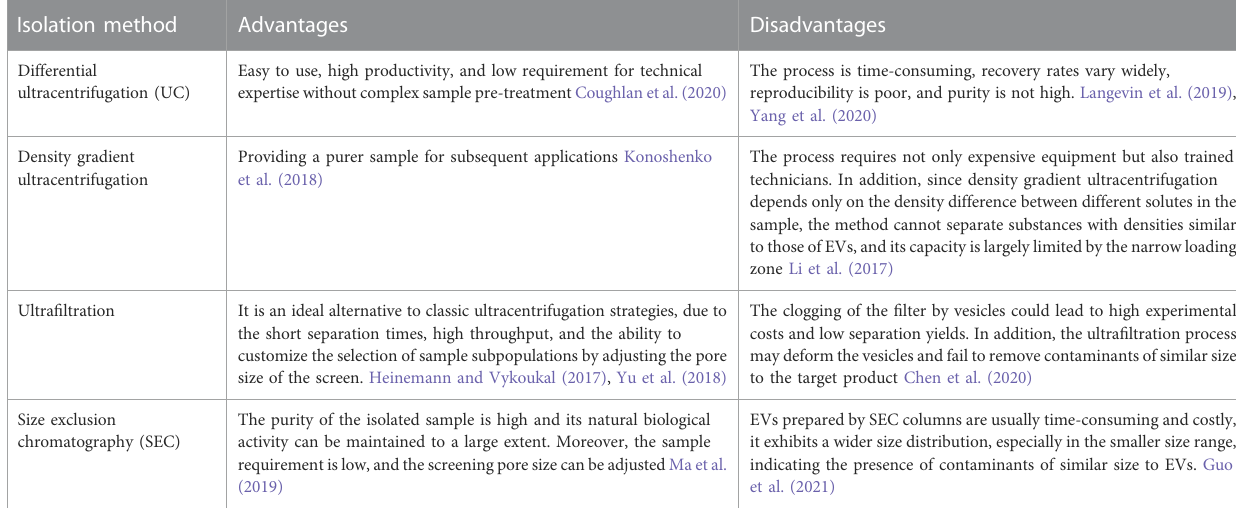
TABLE 2 The advantages and disadvantages of the mainstream EVs isolation